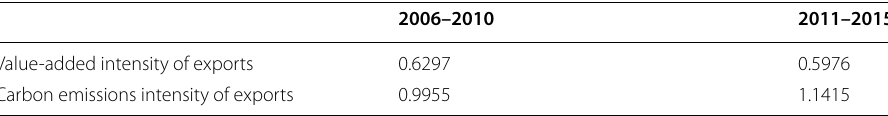
Table 4 Carbon intensity and value-added intensity of exports